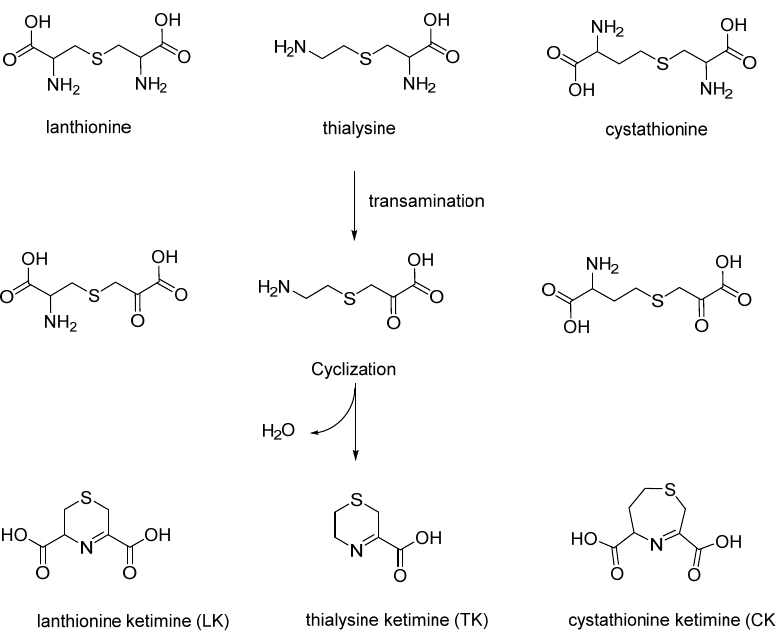
Figure 4. Sulfur-containing cyclic ketimines found for the first time by Professor Cavallini as human sulfur metabolites.